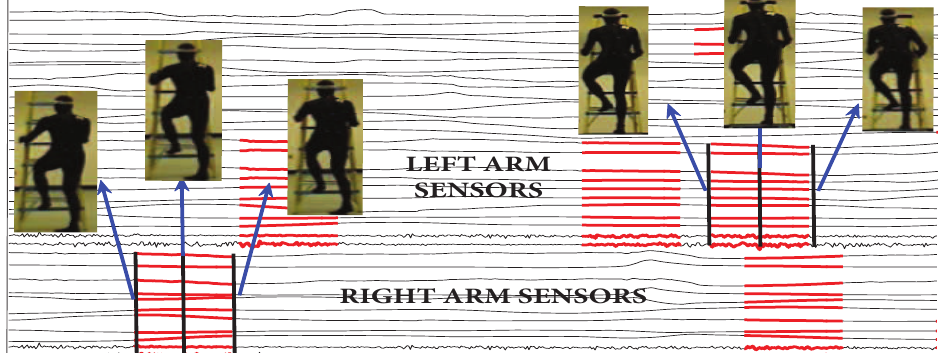
Figure 2. In this motion snippet (from MoCap [10]), the repeated pattern (climbing action) occurs on different sets of variates—alternately on sensors on the right and left